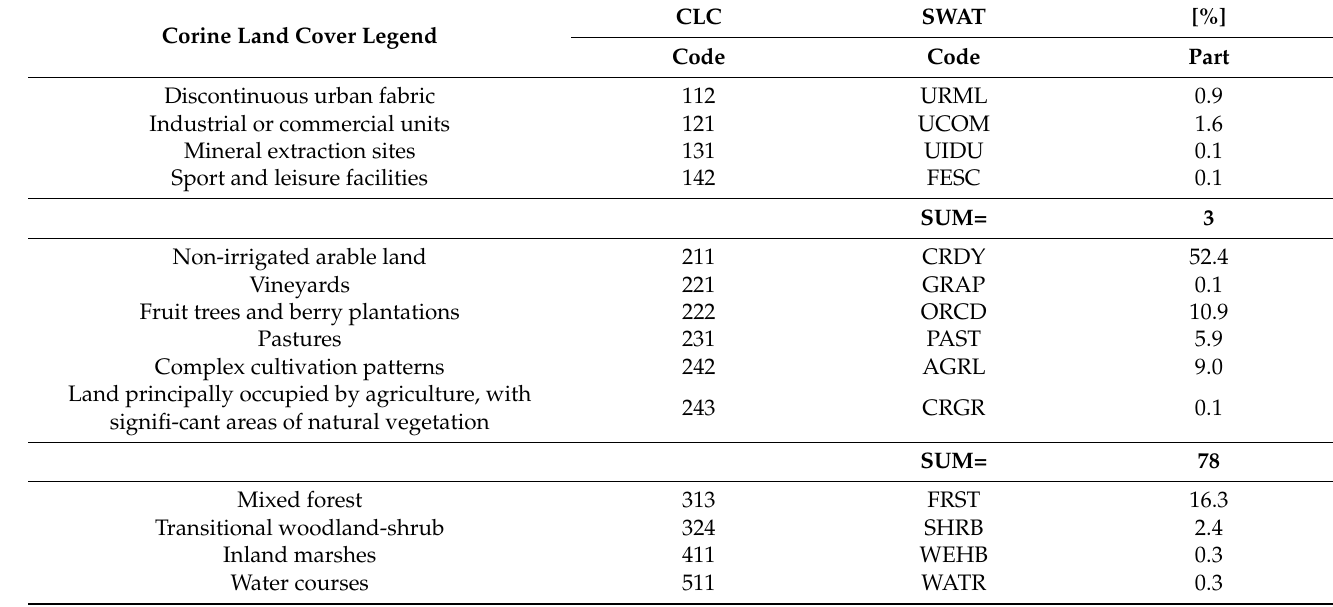
Table 2. Division of the cover and use as well as the percentage of use in the Bystra basin generated in the QSWAT interface (own